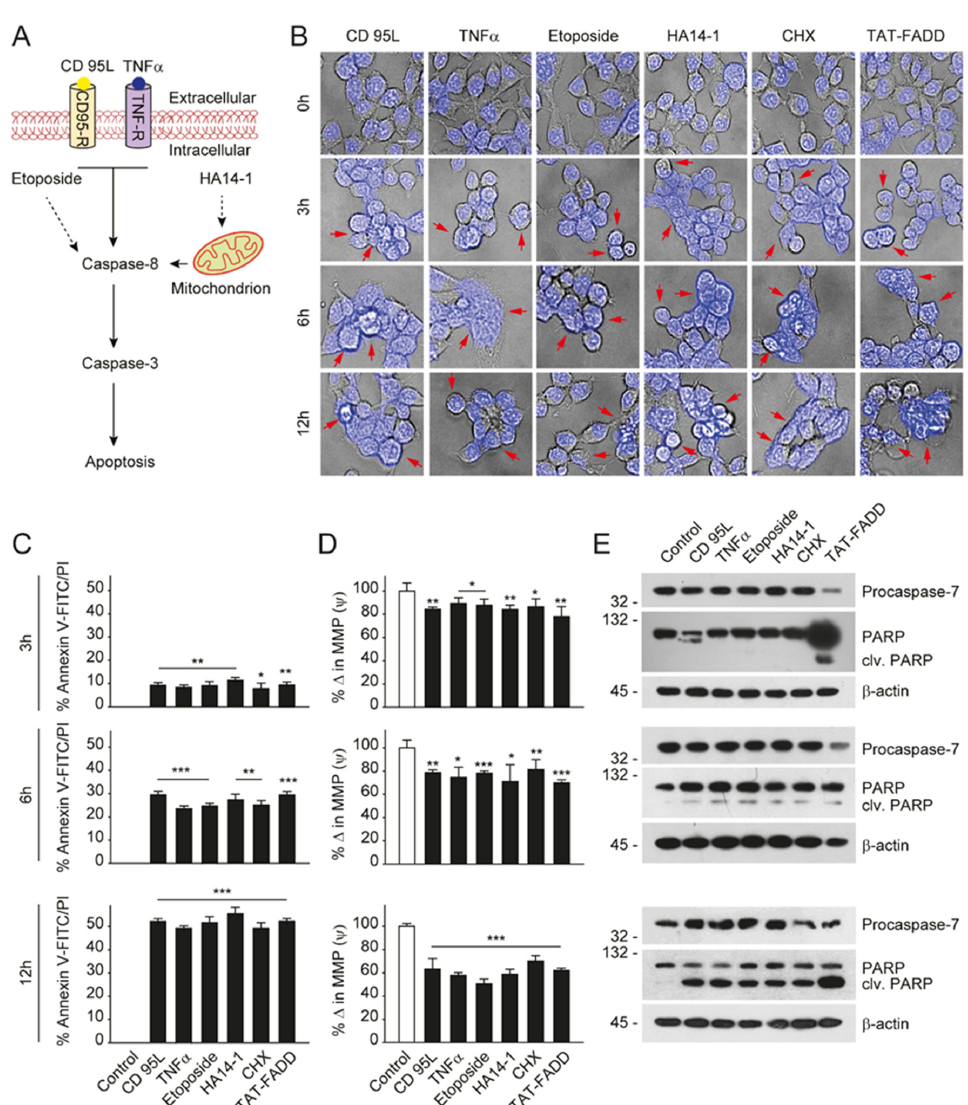
Figure 4. TAT ‐ FADD’s pro ‐ apoptotic effect is compared with conventional apoptosis inducers. ( A ) Figure 4. TAT-FADD’s pro-apoptotic effect is compared with conventional apoptosis Schematic diagram representing the target site of proposed apoptosis inducers. ( B – E ) HCT 116 cells